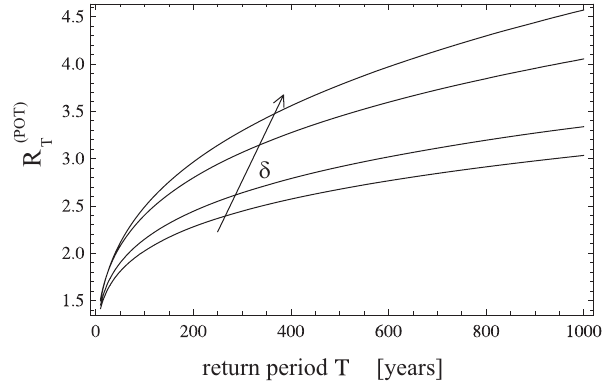
Fig. 3. Relation between the return period ratio R ( POT ) increasing values of δ (0, 365/8, 365/4, 365/2), with a α = a λ =0.5, n =1 and λ 0